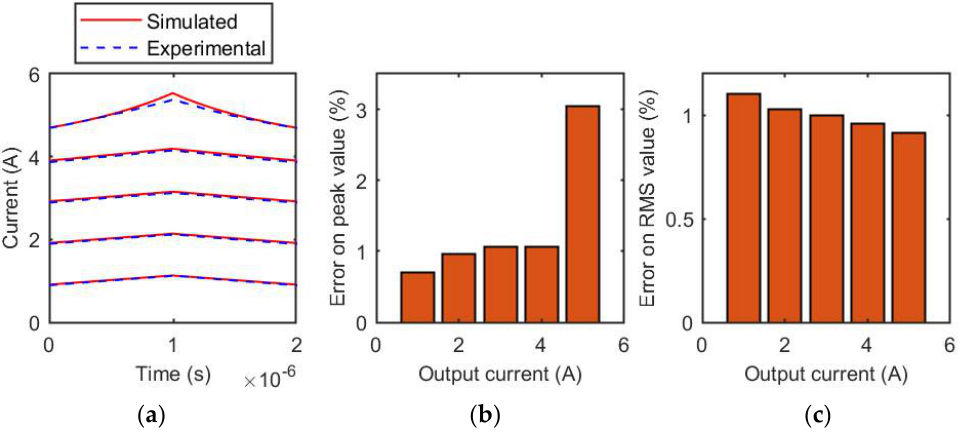
Figure 10. Coilcraft MSS1260T-273 inductor, 12 V. ( a ) Comparison of experimental and simulated current waveforms for different output current values; ( b ) relative error of the estimation of the peak value of the inductive current; ( c ) relative error of the estimation of the RMS value of the inductive current.